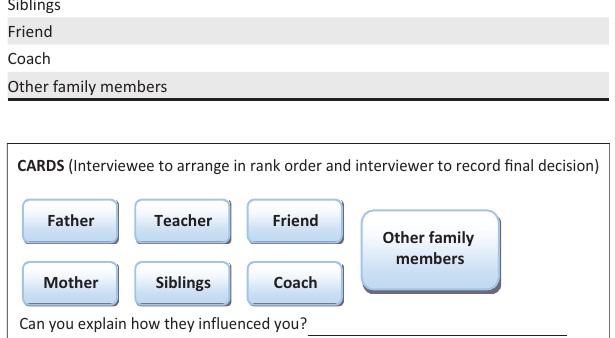
FIGURE 2: Choose words that are applicable to you when you are performing mathematical accounting calculations and arrange in rank order.